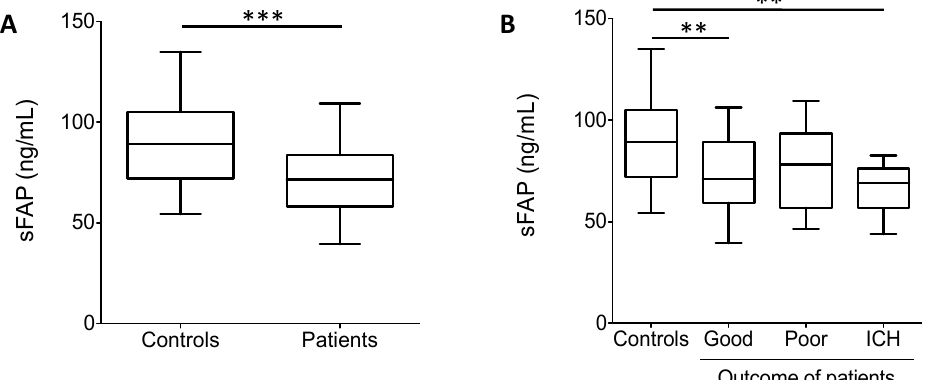
Figure 4. ( A ) Soluble fibroblast activation protein (sFAP) levels in controls and in the total cohort of patients. sFAP levels were significantly lower in patients as compared to healthy controls. ( B ) sFAP levels in controls and in patients according to different outcomes. Box and whisker plots indicate median, interquartile range, and total range. **, p < 0.01, ***, p < 0.001. Table 2. Correlation of different parameters with the extent of α2-PI incorporation into fibrin clots. Control −0.449 (0.001) Values represent Pearson’s correlation coefficient and statistical significance, r ( p ). 4. Discussion It has been shown by elegant studies that the stability of the newly formed thrombi against premature fibrinolysis predominantly depends on the cross-linking of α2-PI into the fibrin clot [34,35]. Despite the great importance of this regulatory step and its poten- tial influence on a wide range of thrombotic clinical events, surprisingly little is known on the extent of α2-PI incorporation into the fibrin clot under various circumstances.